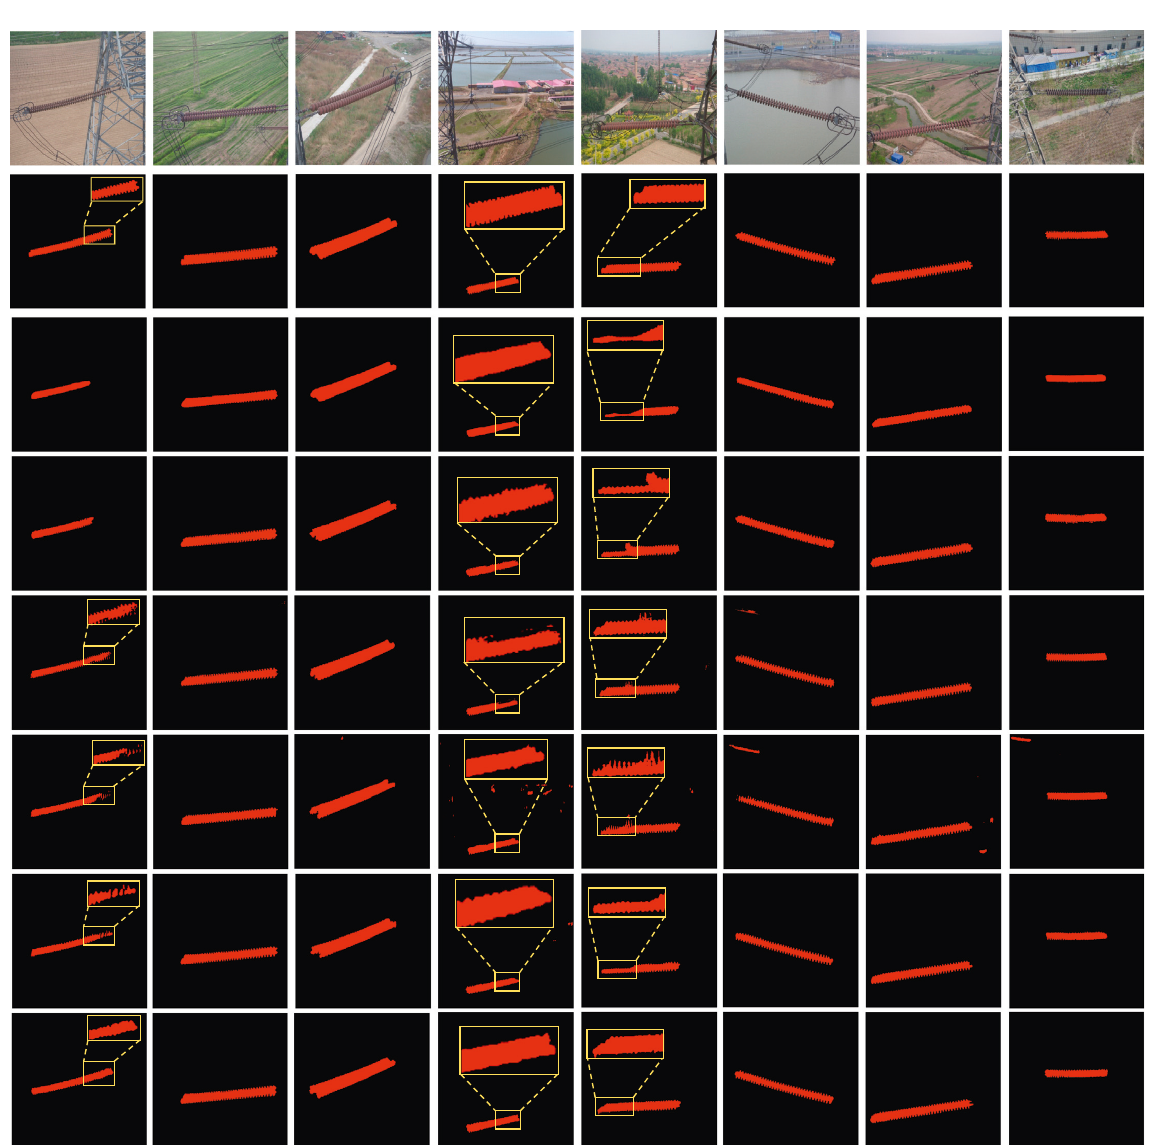
Figure 9: In the insulator test dataset, the ROC curves are generated by ED-Net and mainstream segmentation models.